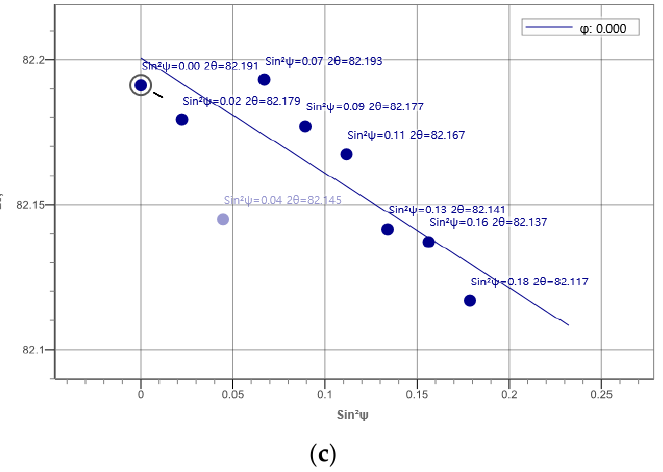
Figure 14. Residual stress diagrams of the peened overlap-defect specimen. ( a ) Heat-affected zone; ( b ) Upper region of the bead; ( c ) Middle region of the bead.